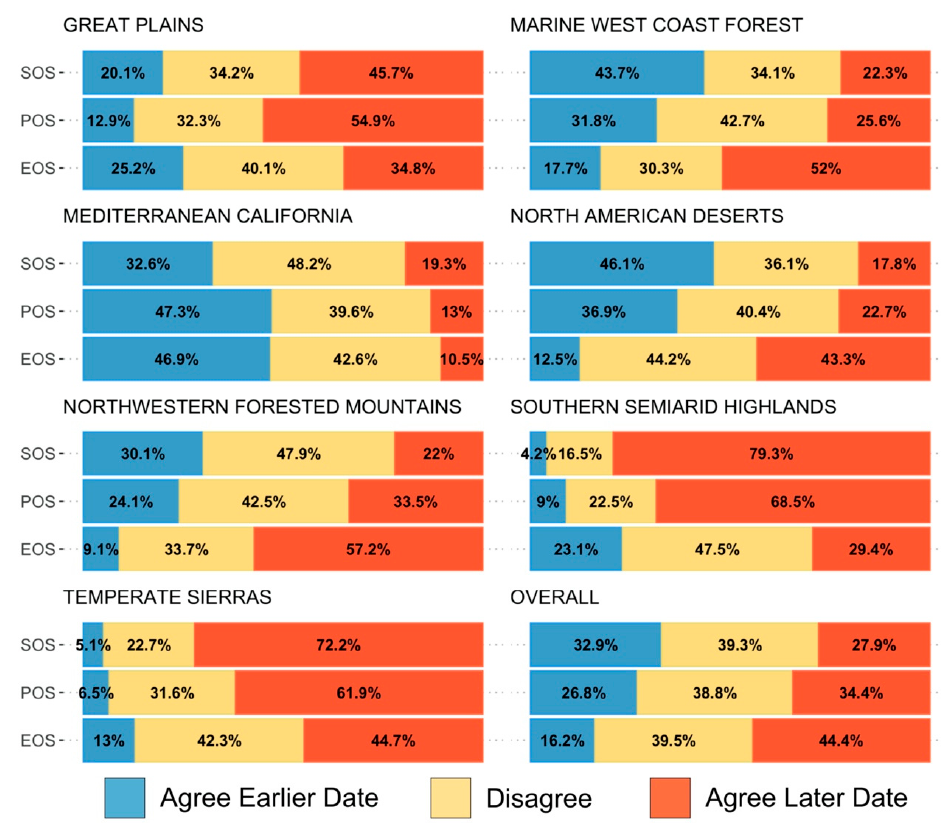
Figure 6. Consistency of CMGLSP and VIPPHEN_EVI2 long-term (1982–2016) trend direction over the entire study area and classified by ecoregion.